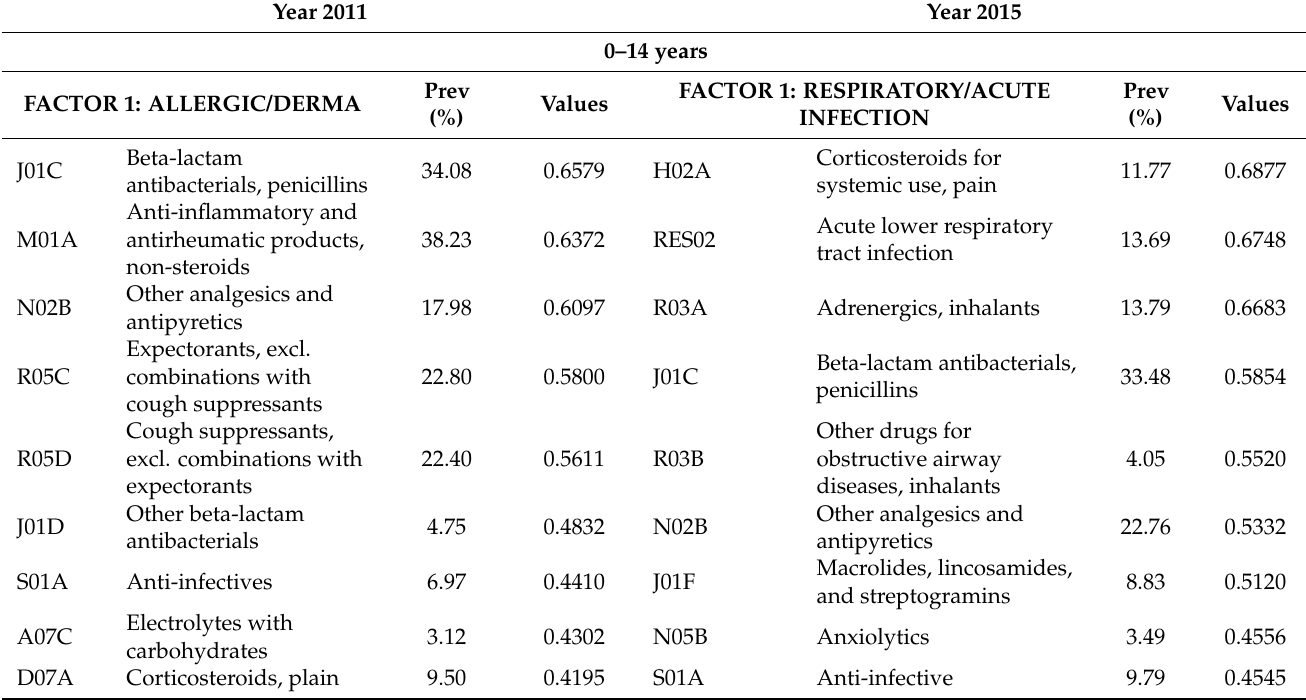
Table 5. Patterns of chronic diseases (EDC codes) and drugs (ATC codes) and factor loading scores in men. Diseases are highlighted in